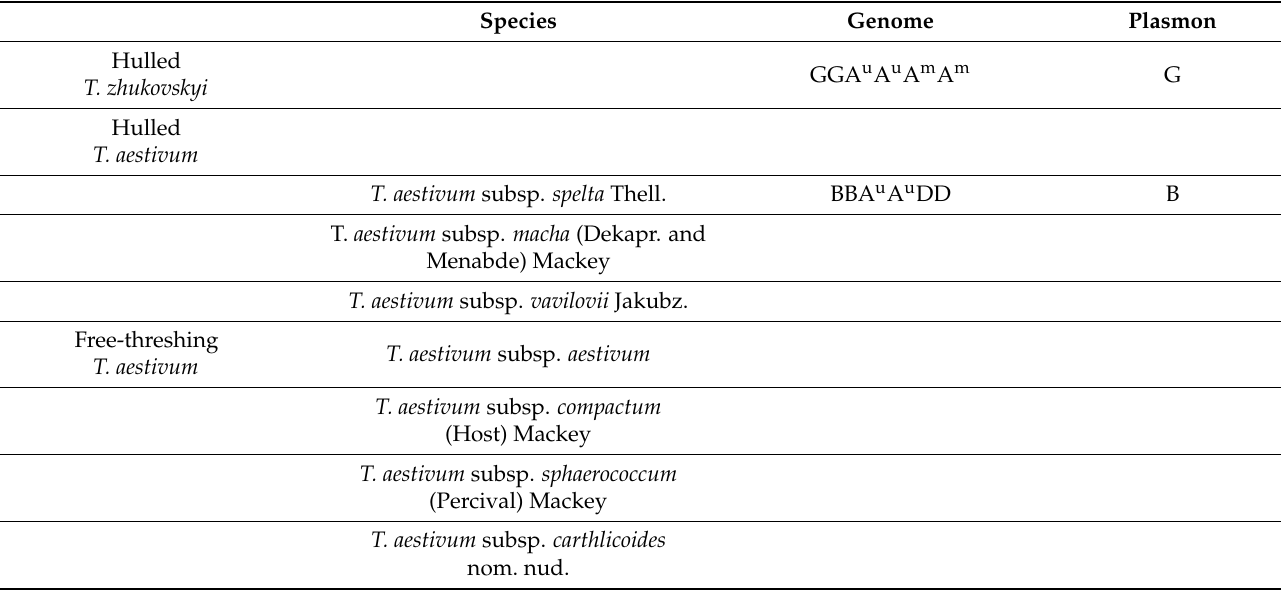
Table 1. List of hexaploid wheats.